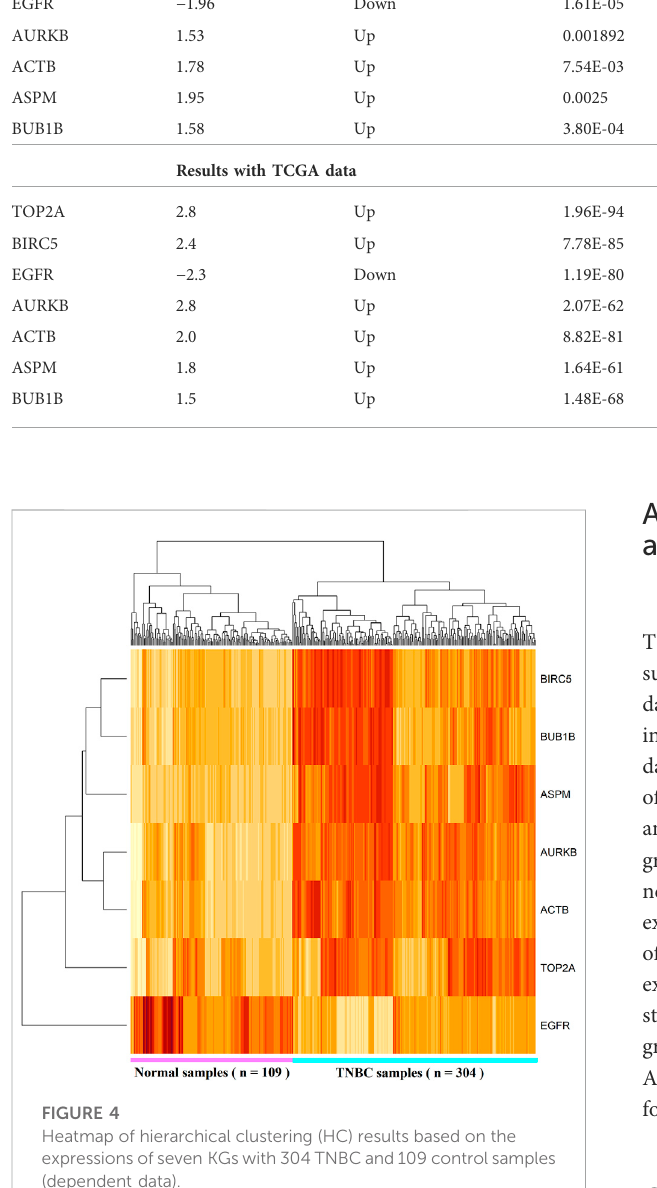
clearly separated KGs into upregulated and downregulated groups, and samples/patients in TNBC and control groups.